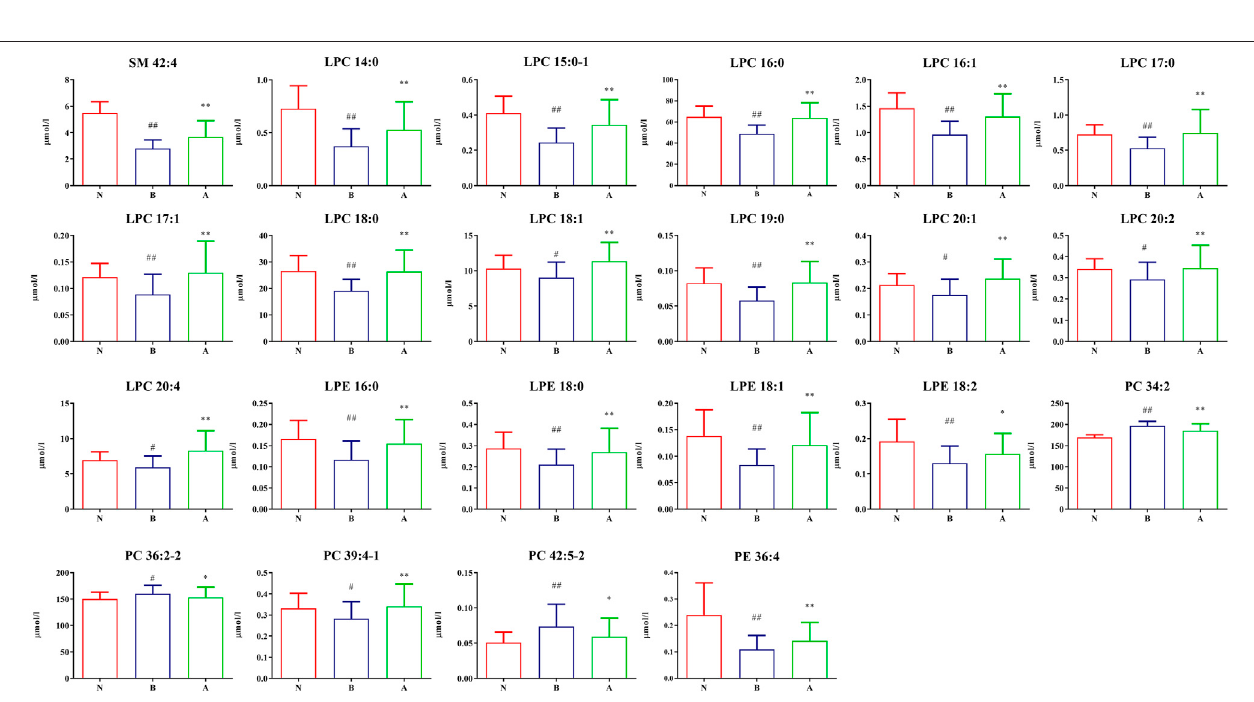
FIGURE 9 | The differentially expressed lipid concentration of each group under positive ion mode. (N) Healthy control group; (B) Oral disease group; (A) HLJDD intervention group. Groups N and B ( # p < 0.05, ## p < 0.01); Groups A and B (* p < 0.05, ** p < 0.01).